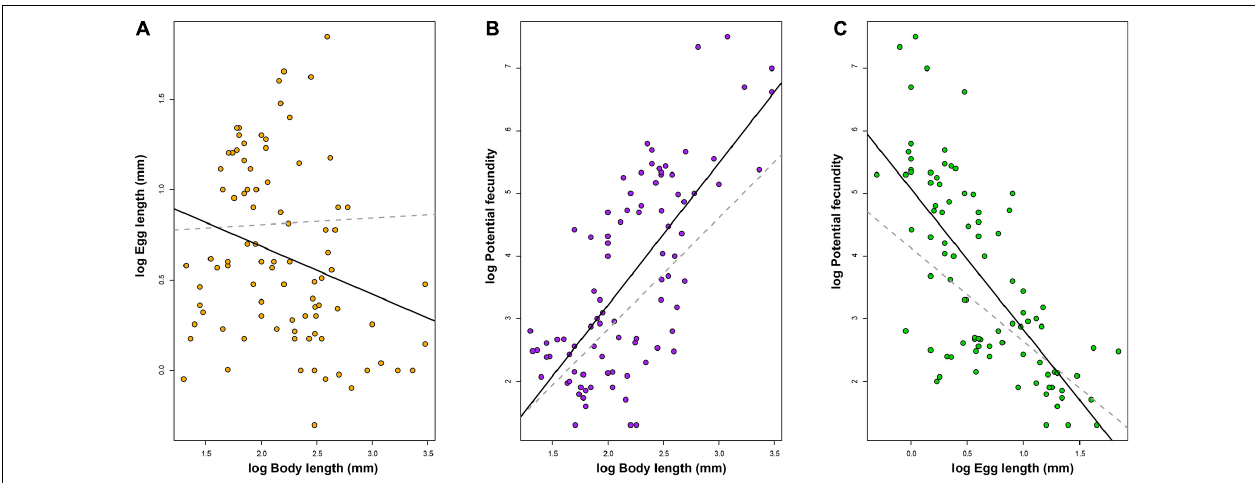
FIGURE 2 | Relationships between reproductive traits of 90 cephalopod species, where (A) body length and egg length, (B) body length and potential fecundity, (C) egg length and potential fecundity. Dashed lines represent regressions from PGLS. Solid lines represent regressions from